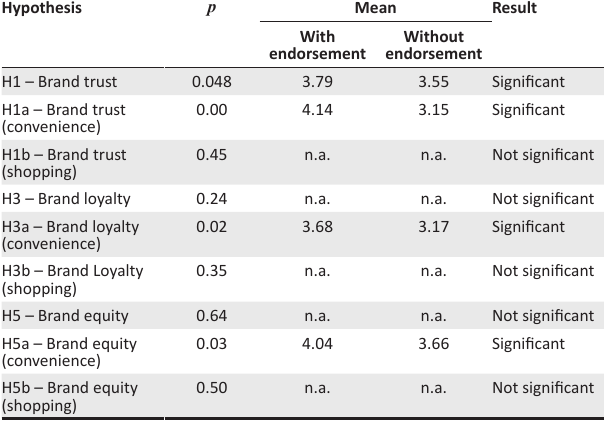
TABLE 4: Summary of statistics pertaining to objective